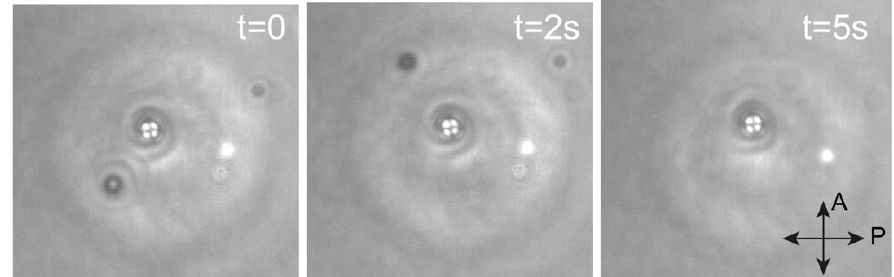
Figure 10. An image sequence of the radial droplet trapped by the optical tweezer. Crossed brushes represent +1 defect confined in the middle of the droplet.